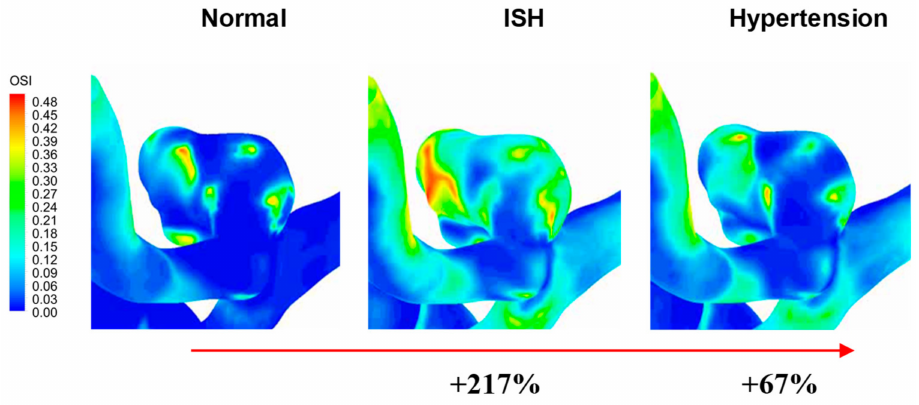
Figure 11. OSI distribution in A-3 model, and for each pressure condition.